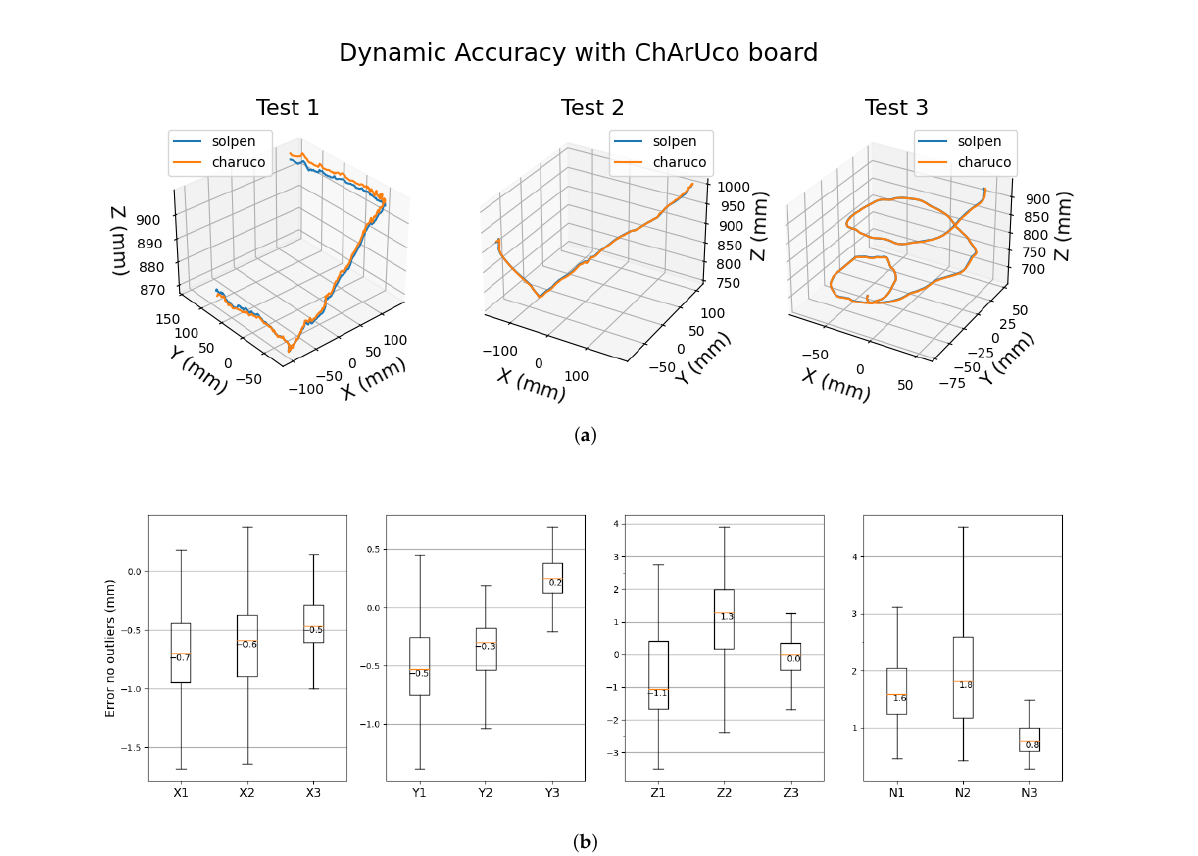
Figure 16. Dynamic error analysis—trajectory of ChArUco board origin versus pentip. ( a ) Trajectory illustration. ( b ) Dynamic error box plots for the trajectories. The first three box plots are the per-axis errors and the last plot represents the norm error of the